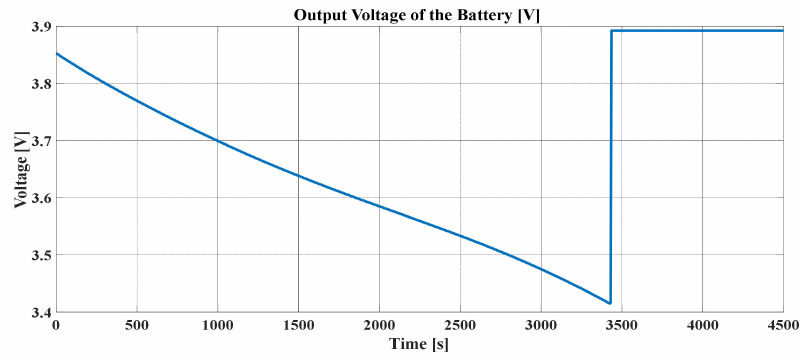
Figure 12. Cell output voltage (TPM).